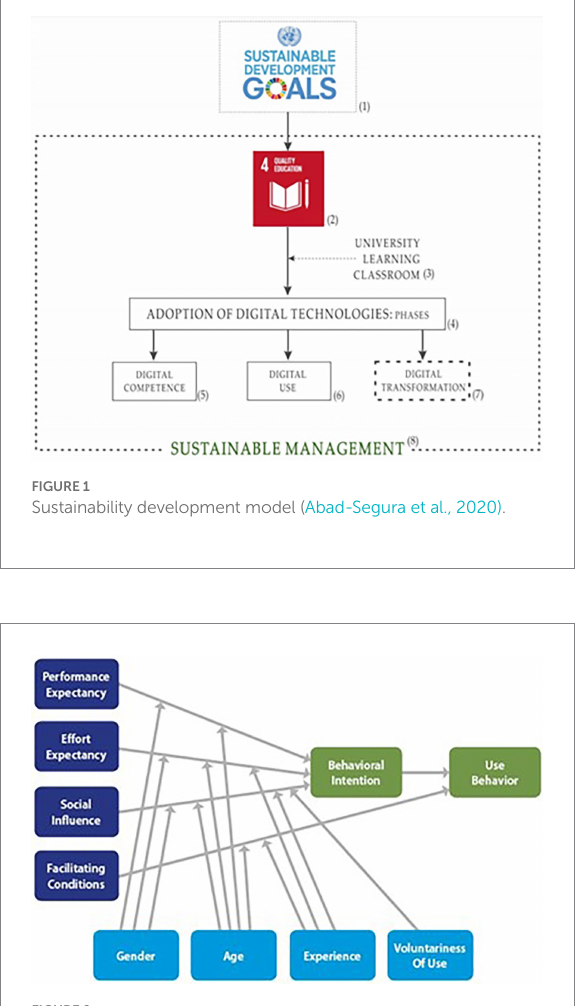
FIGURE 2 Unified theory of acceptance and use of technology (UTAUT; Venkatesh et al.,